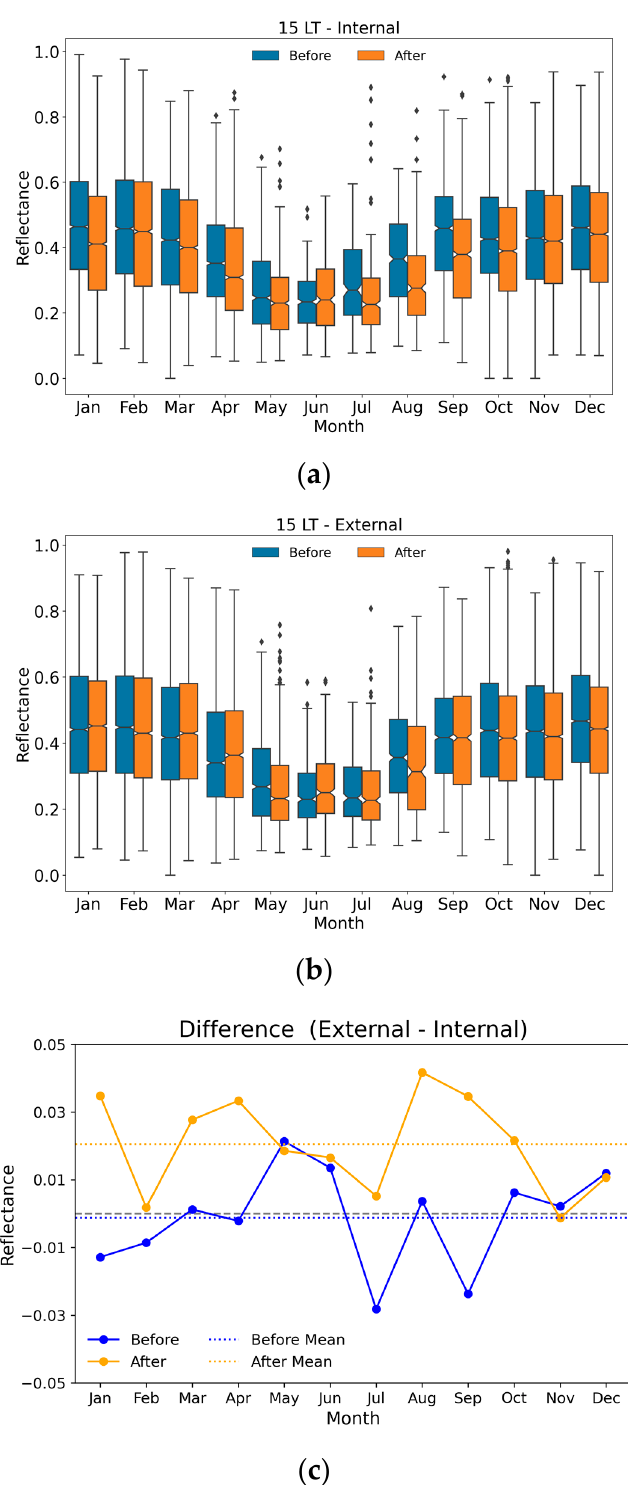
Figure 14. Boxplot for the monthly visible reflectance observed in the internal ( a ) and external ( b ) reservoir area at 15h LT before (blue boxes) and after (orange boxes) construction of the Serra da Mesa hydropower plant. Panel ( c ) shows the difference between external and internal areas for the period before and after lake filling. The box represents the interquartile range (IQR) (25–75%), and the whiskers are the +/- 1.5 × IQR bounds of data values. The notch (horizontal line) indicates the median (95% confidence). Overlapped notches mean the datasets are not significantly different at 95% confidence level [52].